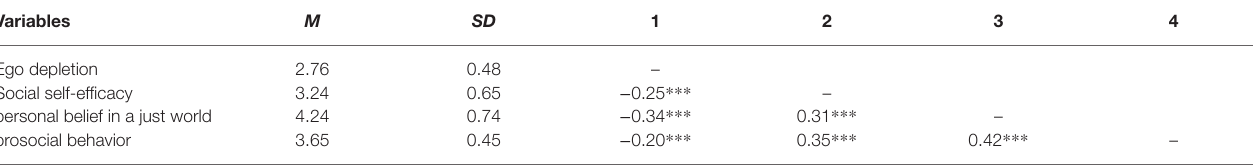
TABLE 1 | Descriptive statistics and correlation analysis of the variables involved in this measurement ( N = 1,122). Variables M